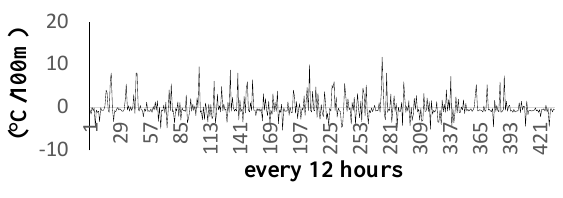
Figure 14 . Temperature inversion for every 12 ℎ in 2013